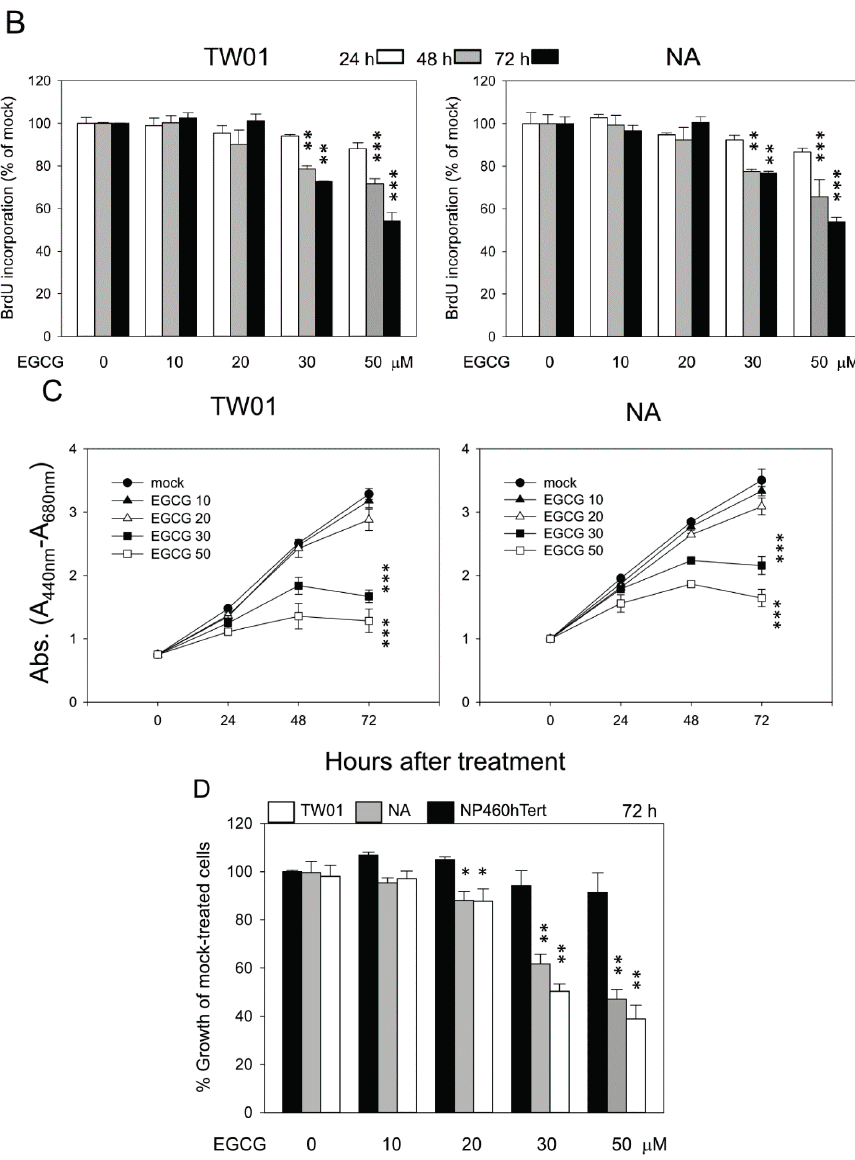
Figure 1. ( − )-Epigallocatechin-3-gallate (EGCG) inhibits the proliferation of nasopharyngeal carcinoma (NPC) but not immortalized NP460hTert cells. ( A ) The chemical structure of EGCG; ( B ) The proliferation of TW01 and NA cells under EGCG treatment. Cells were treated with various concentrations of EGCG (0, 10, 20, 30 and 50 μ M) for 24, 48 and 72 h. The proliferation of cells is presented as % BrdU incorporation of mock-treated cells. Data indicate the average value of triplicates (mean ± SD). **: p < 0.01; ***: p < 0.001, compared to mock-treated cells; ( C ) The viability assay of TW01 and NA cells under EGCG treatment. Cells were treated with various concentrations of EGCG for 24, 48 and 72 h. The viable cells were determined using a standard WST-1 assay. The X axis represents the absorbance value of (A 440 nm − A 680 nm ). Data indicate the average value of triplicates (mean ± SD). ***: p < 0.001, compared to mock-treated cells; ( D ) TW01, NA and NP460hTert cells were exposed to various concentrations of EGCG for 72 h. The viability of cells is presented as % growth of mock-treated cells. Data indicate the average value of triplicates (mean ± SD). *: p < 0.05; **: p < 0.01, compared to the NP460hTert